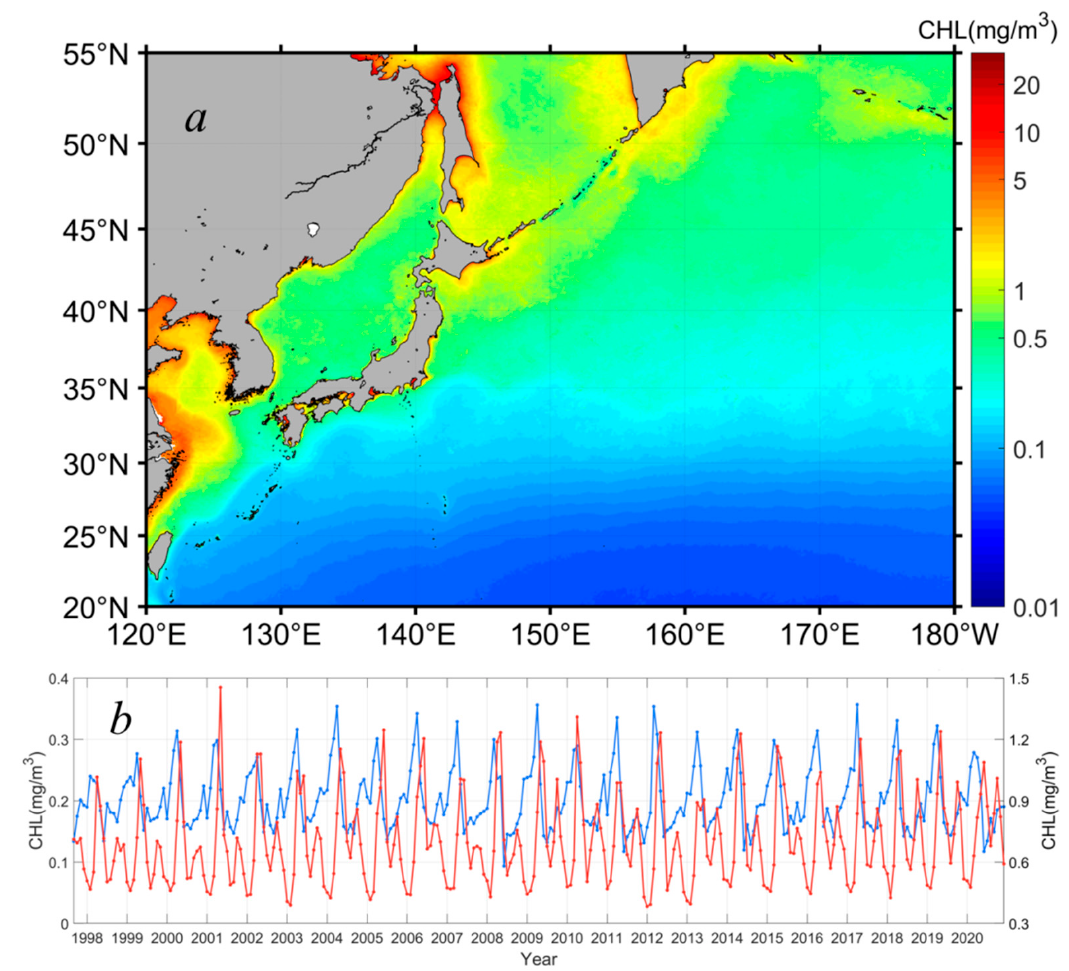
Figure 4. Spatial distribution of the yearly Chl-a, on average, in 1997–2020 ( a ), and Chl-a interannual data time series ( b ) in the subpolar (i.e., poleward of the Kuroshio extension along 36°N, red curve) and subtropical (i.e., equatorward of the Kuroshio extension along 36°N, blue curve) waters of the northwest Pacific (Kuroshio extension southward and northward).